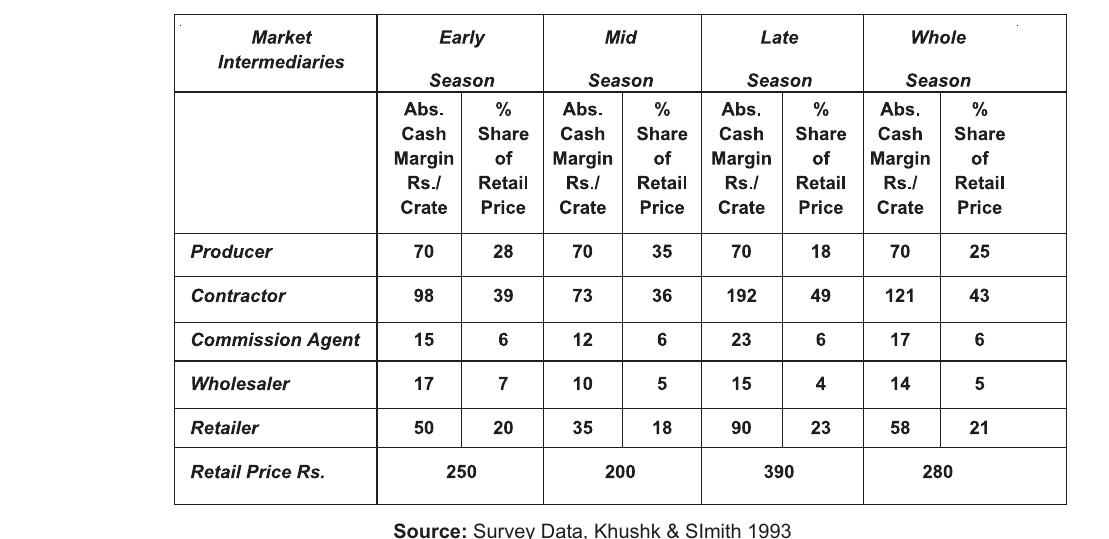
Table: 1 Market Margins of Mango Producers and other Market Intermediaries